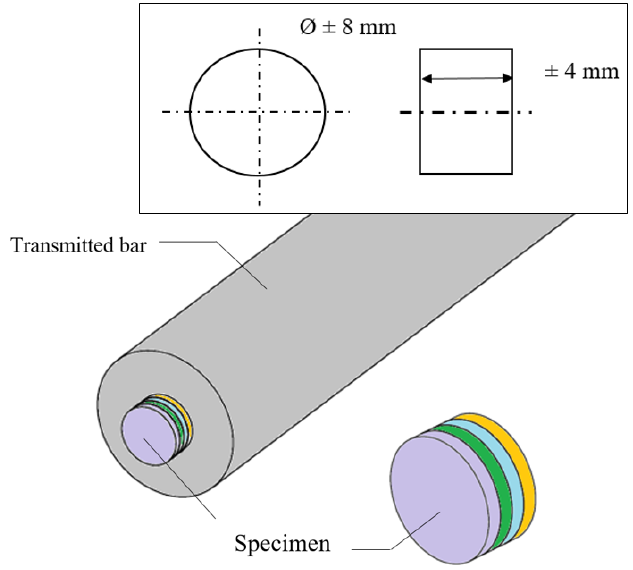
Figure 4. Geometry of the compression test specimen in dynamic compression.